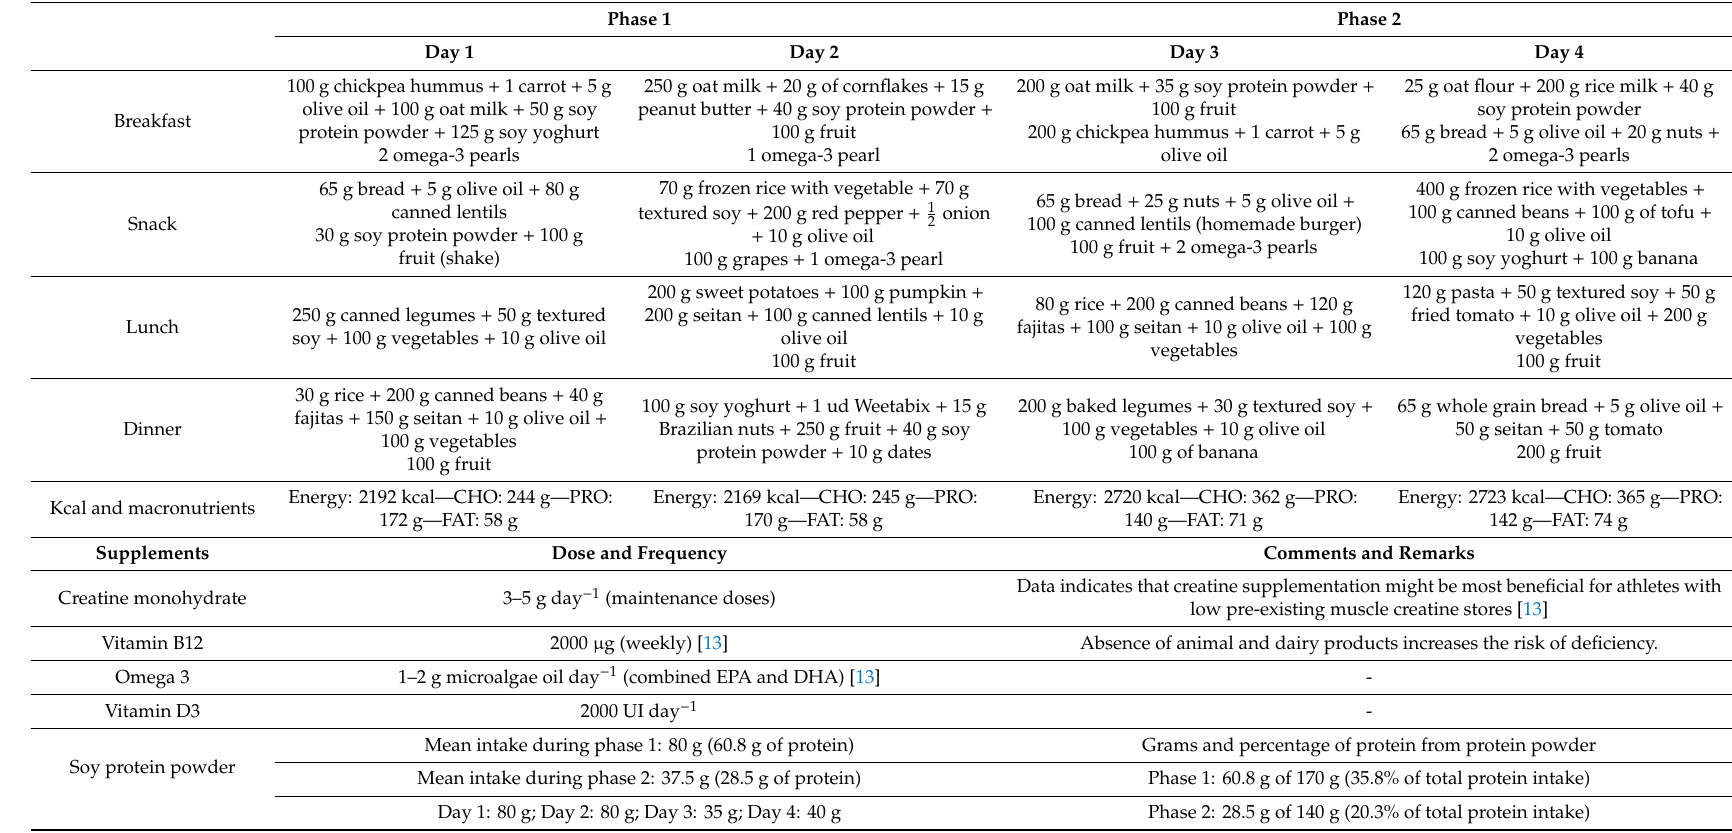
Table 1. Example of vegan diet planning for phase 1 and